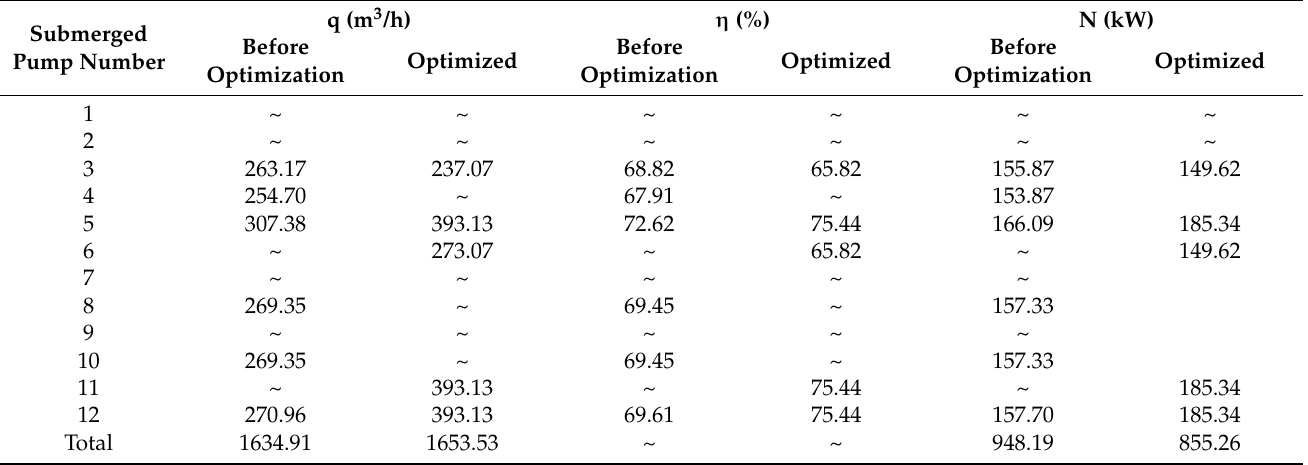
Table 2. Optimization results of the operation plan under the current LNG submerged pump configuration plan of an LNG receiving